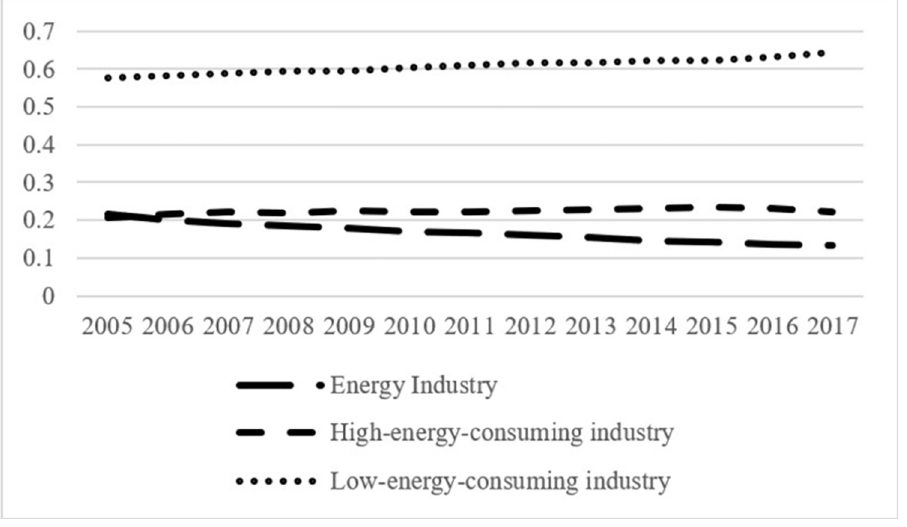
Fig 3. Changes in the internal industrial structure of industry during 2005–2017 (proportion of added value of